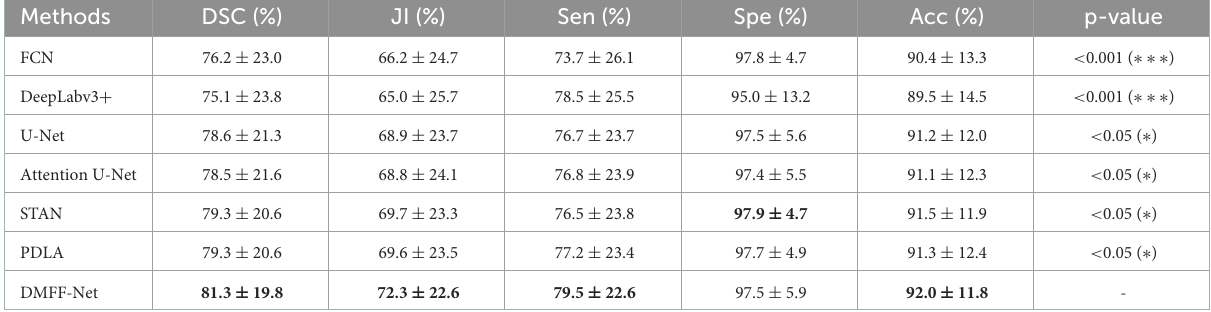
TABLE 7 Quantitative comparison of skin lesion segmentation results between DMFF-Net and other medical image segmentation